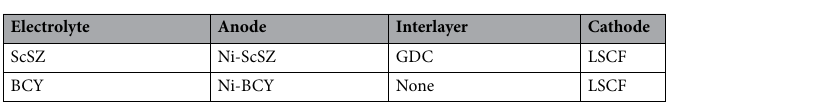
Table 1. Cell configurations of SOFCs supported on ScSZ electrolyte and PCFCs supported on BCY